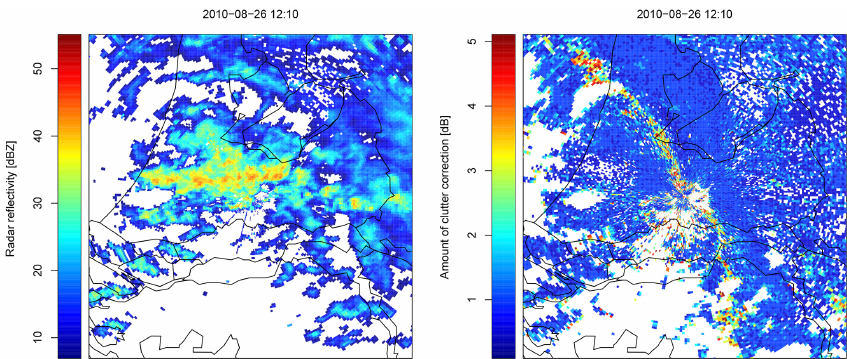
Figure 5. Radar reflectivity (left panel) and amount of clutter corrected by the Doppler notch filter (right panel) for the most intense rainfall peak of episode 4 on 26 August 2010 at 12:10UTC. Images shown are for the 0.8 ◦ elevation